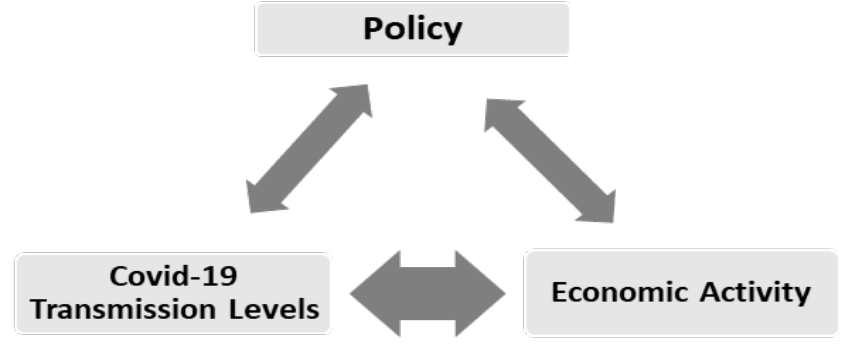
Fig. 1. Relationships between government policies, economy and